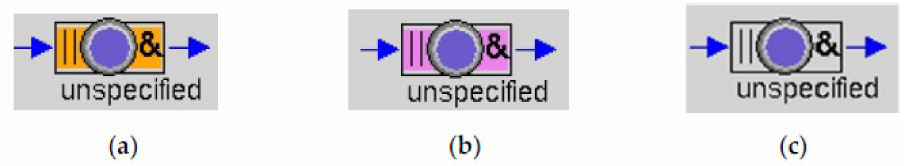
Figure 22. Event type: ( a ) root cause event; ( b ) alarm event; ( c ) unspecified event.